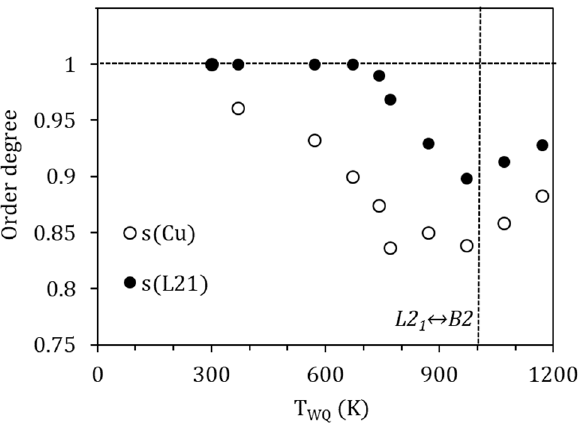
Figure 9. Calculated degrees of order after quenching from different temperatures.